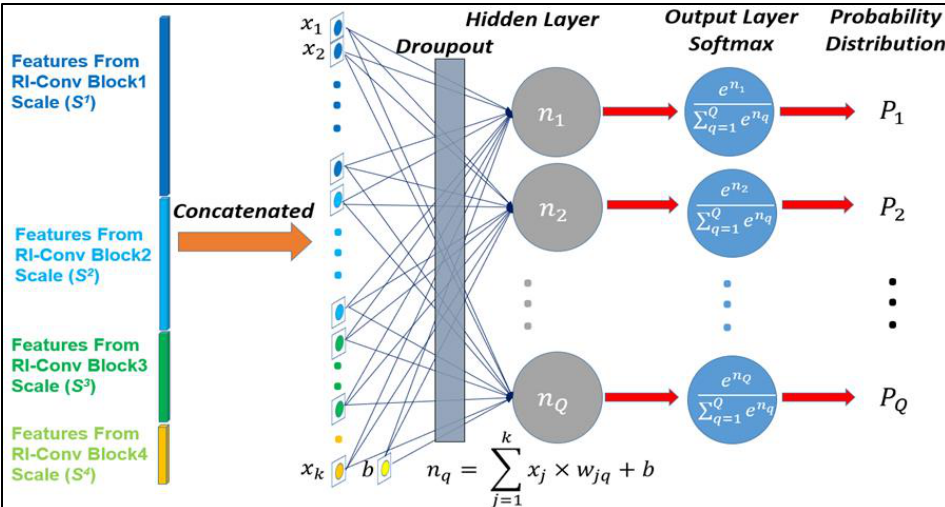
Figure 10. Image classification structure.